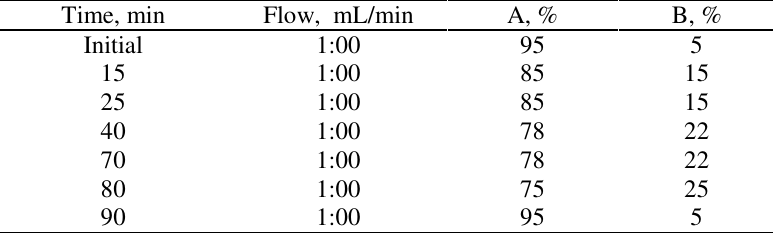
Table 1. The gradient